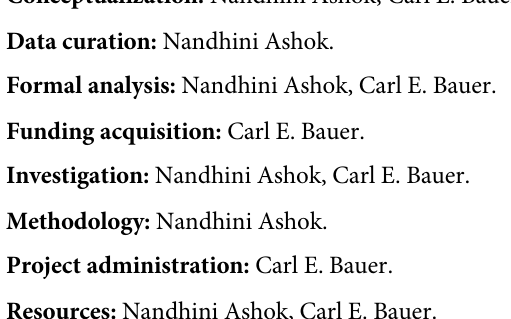
S19 Fig. Heatmaps show the expression profiles of transport systems expressed at the mid- dle to late time points of germination. (A) ABC transporters specific for sugar transport. (B) Branched-chain amino acid transport. (C) Putrescine transport. (D) Oligopeptide transport. (E) Potassium transport. (F) Active transport of potassium. (G) Copper transport. Color of boxes are as noted in S3 Fig and the numbers represent the log fold change. 2 S20 Fig. Heatmaps show the middle to late expression profiles of exbB and exbD that code for TonB receptor components involved in transport across the inner membrane (A) and various TonB dependent outer membrane receptors (B). Color of boxes are as noted in S3 Fig and the numbers represent the log fold change. 2 S21 Fig. Heatmaps show the expression profiles of holo-enzyme RNA polymerase subunits (A) and sigma factors (B). Color of boxes are as noted in S3 Fig and the numbers represent the log fold change. 2 S22 Fig. Time line showing the point of significant expression changes of every differentially regulated transcription factor in this dataset (A). Heatmaps showing the expression profiles of down regulated (B) and upregulated (C) transcription factors. Heat maps on the left side of B and D are derived from RNA-seq data sets during cyst germination while the heat maps on the right side are from RNA-seq data sets during cyst formation. Color of boxes are as noted in S3 Fig and the numbers represent the log fold change. 2 S23 Fig. Heatmaps show the expression profiles of histidine kinases (A), response regulators (B) and the che3 gene cluster involved in cyst development (C). Heat maps on the left side are derived from RNA-seq data sets during cyst germination while the heat maps on the right side are from RNA-seq data sets during cyst formation. Color of boxes are as noted in S3 Fig and the numbers represent the log fold 2